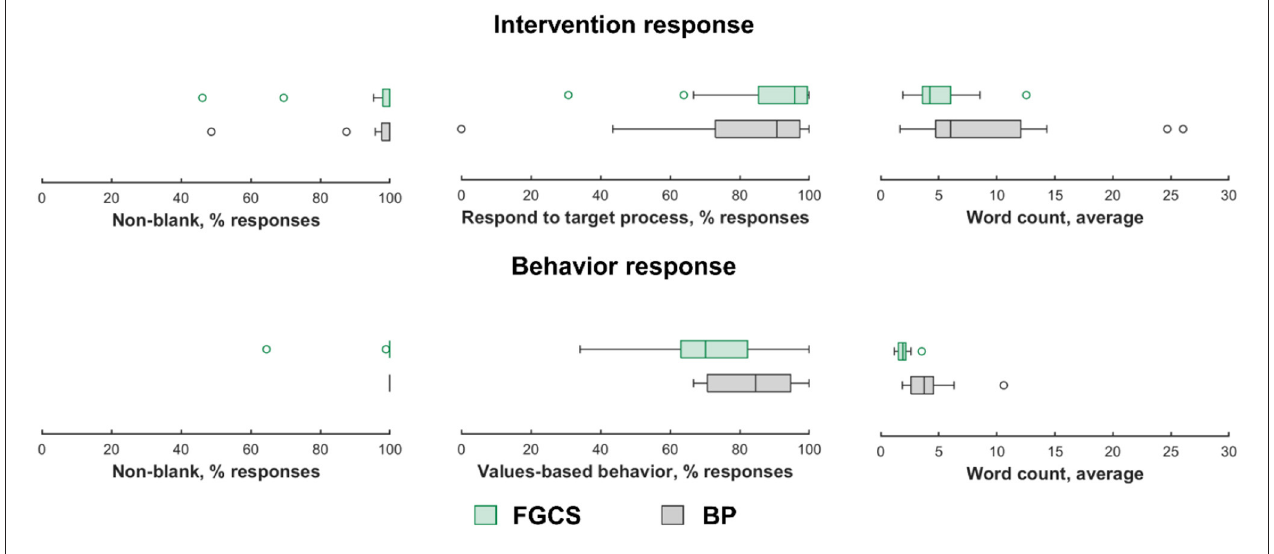
FIGURE 1 | Distribution of metrics of engagement across participants.